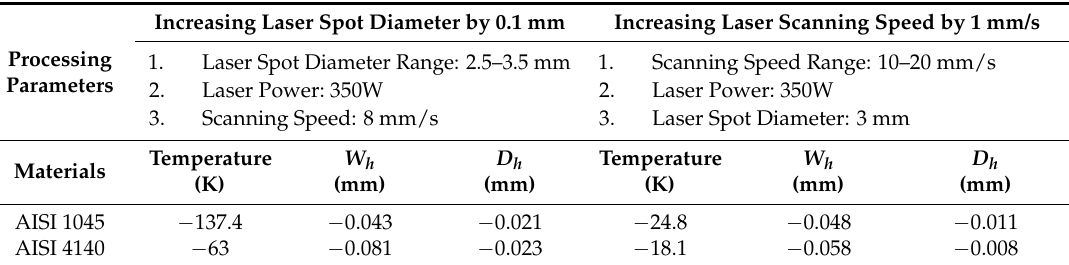
Table 3. Recommended processing parameters to reduce hardening zone